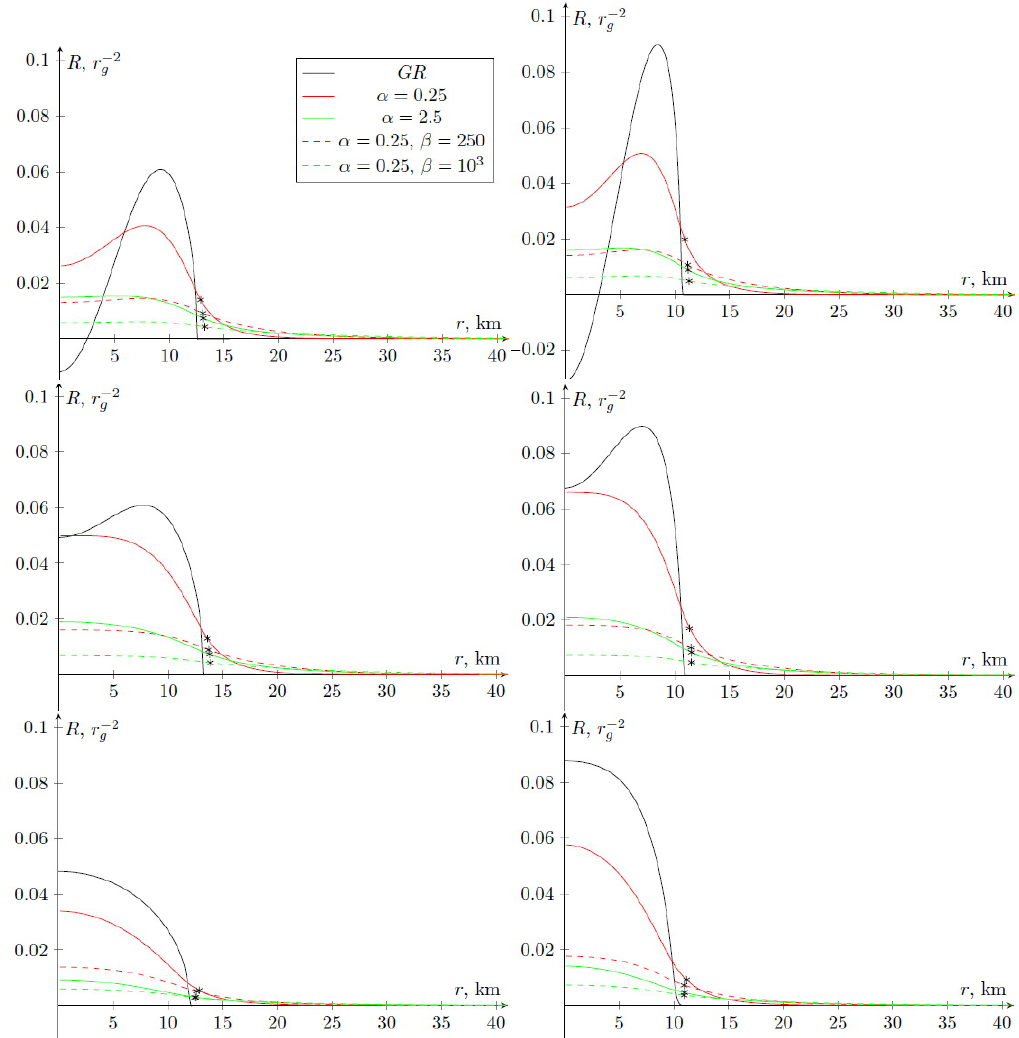
Figure 3. Dependence of scalar curvature (in units of r − 2 g ) on radial coordinates using EoS GM1 (left panel) and APR (right panel) for some values of central density and parameters α and β . For GM1 EoS, (cid:101) c is 800, 500 and 200 MeV/fm 3 (up to down), and for APR, EoS—900, 650 and 400 MeV/fm 3 (up to